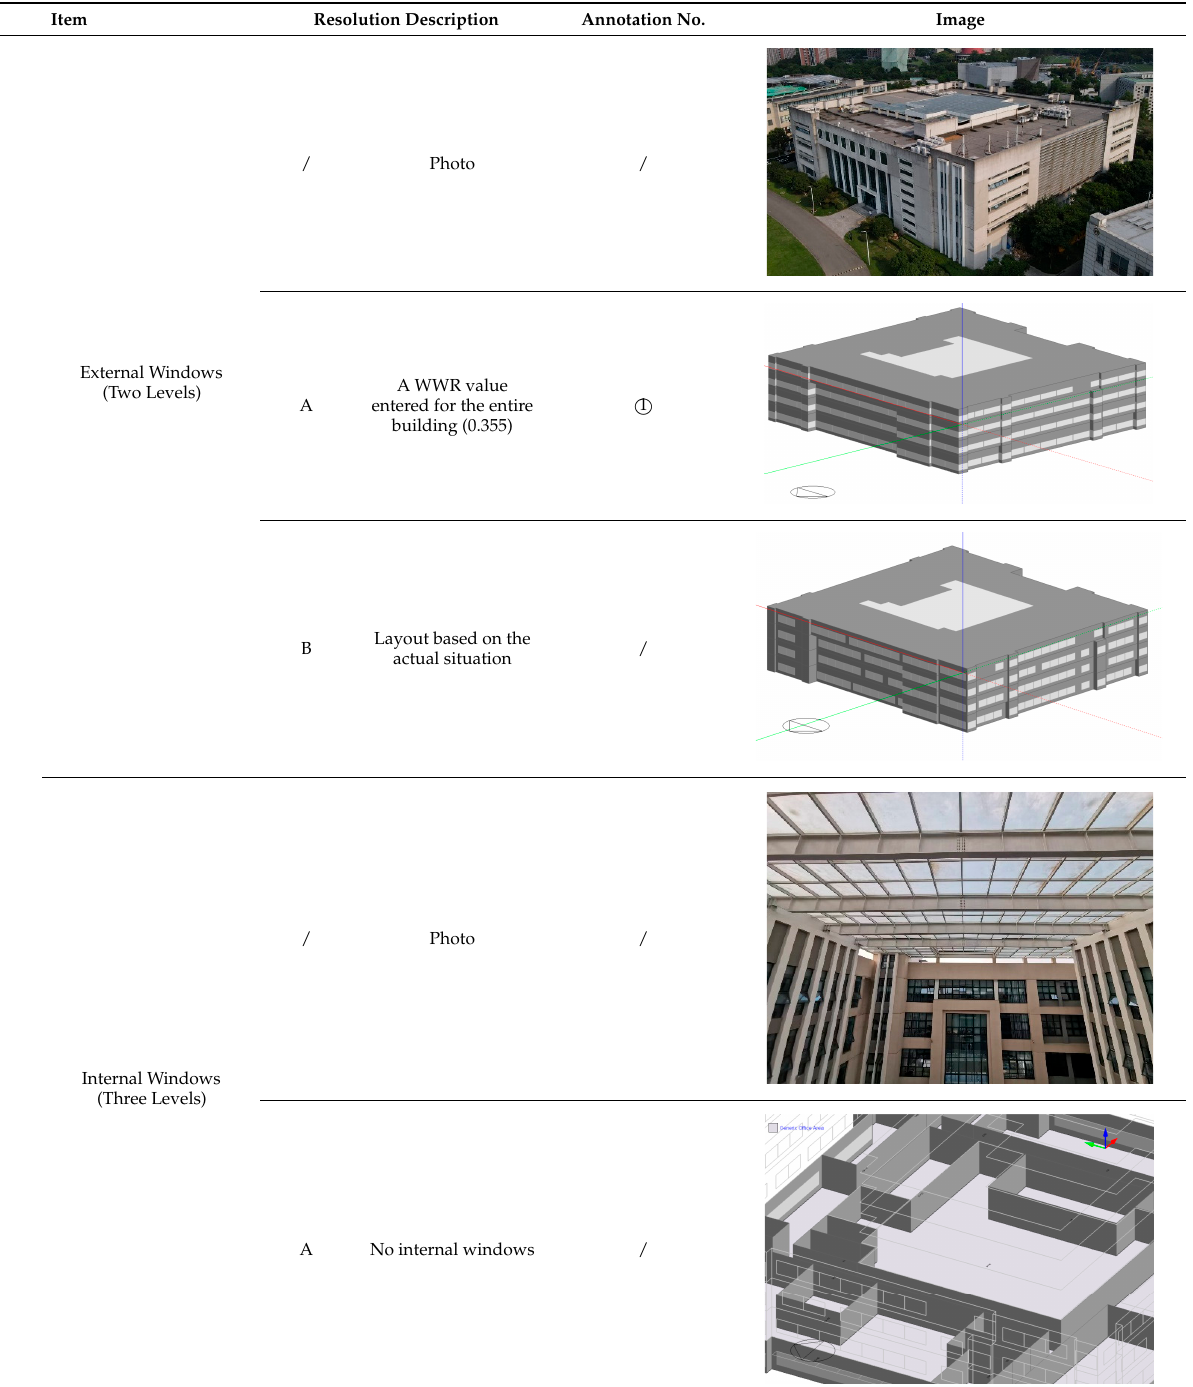
Table 2. Details of model input-data-resolution levels.